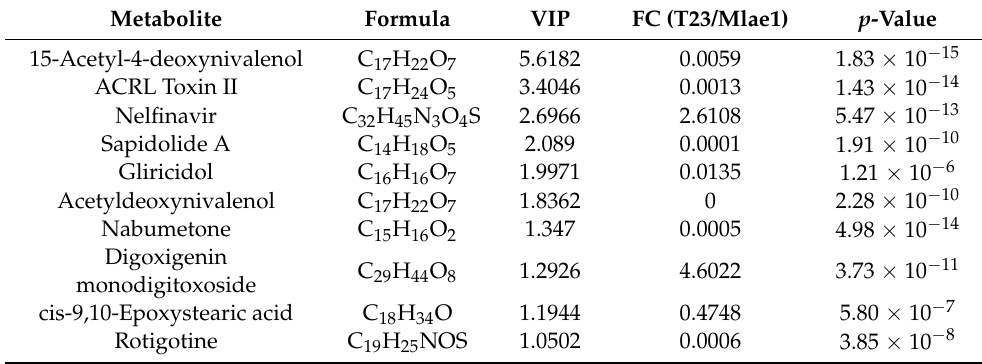
Table 1. Key metabolites with significant differences between T23 and Mlae1 strains.